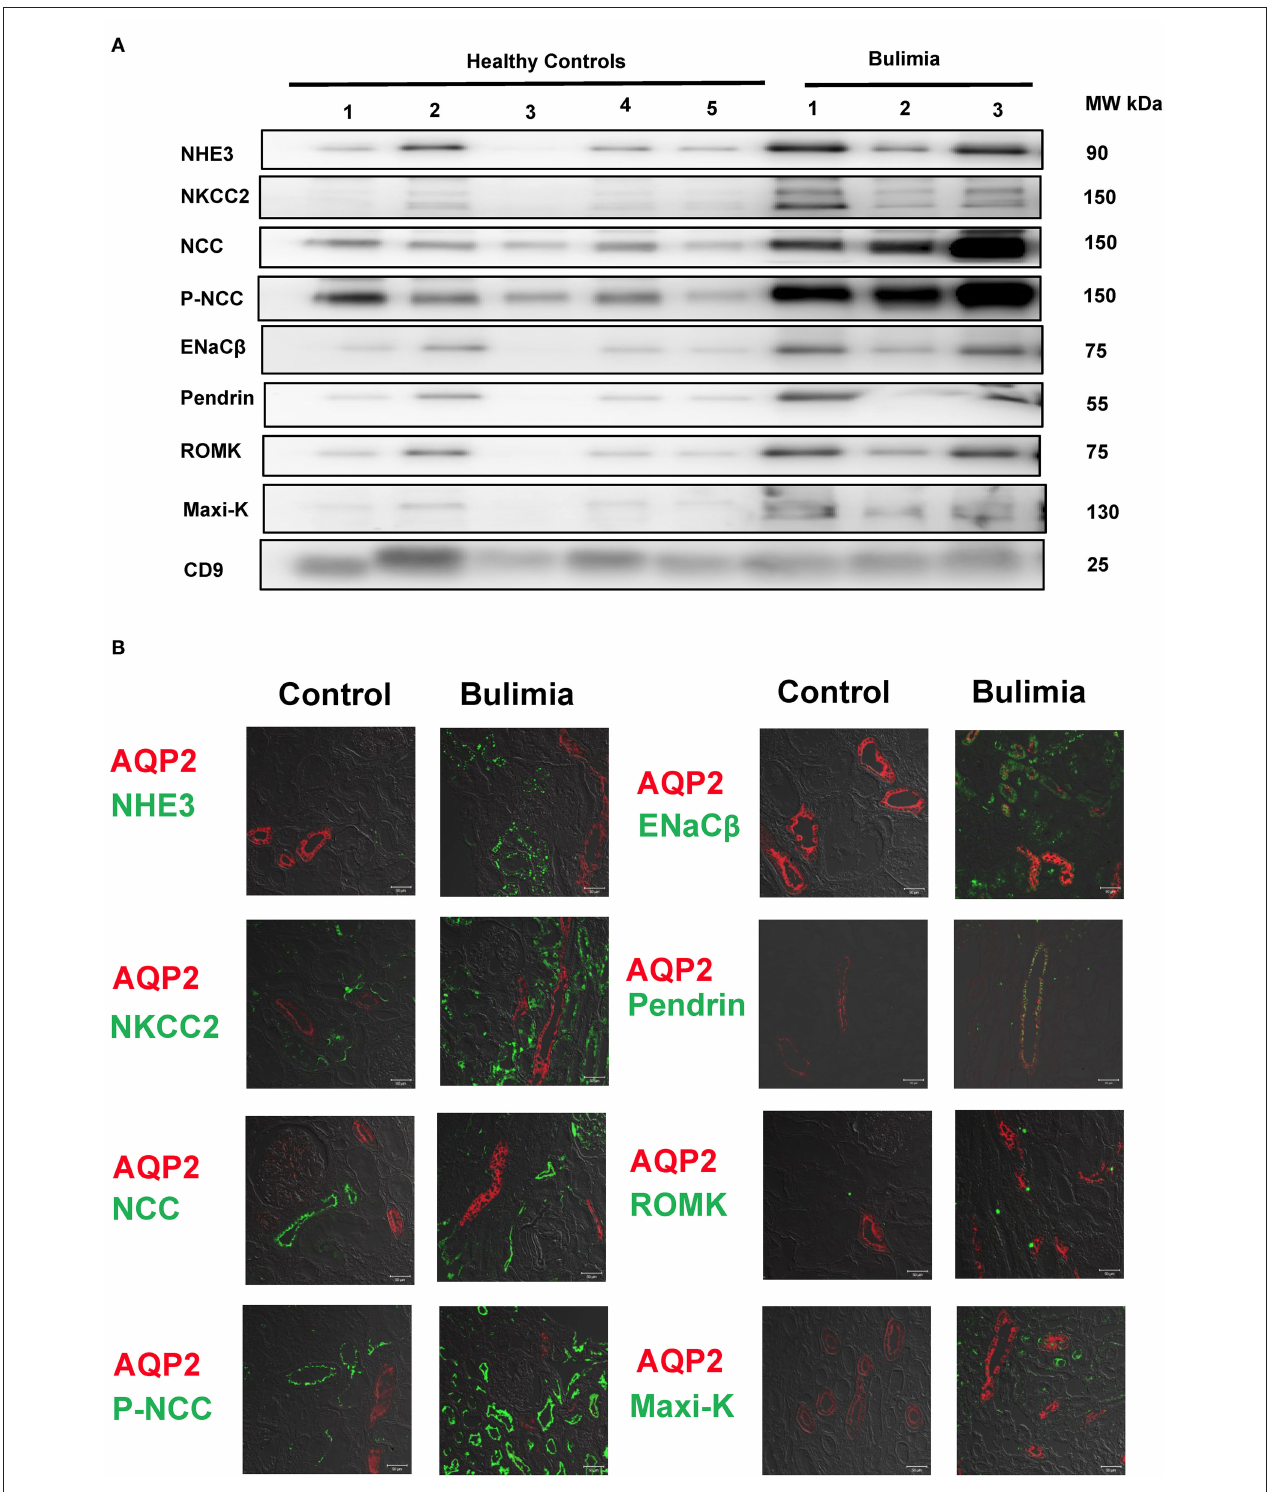
FIGURE 4 | Renal transporters expression from urinary extracellular vesicles (uEVs) and immunofluorescence of biopsied kidney tissues from bulimic patients. (A) Immunoblotting of renal transporters (NHE3, NKCC2, NCC, p-NCC, ENaC β , pendrin, ROMK, Maxi-K, and CD9) from uEVs in bulimic patients ( n = 3) compared with healthy control. (B) Immunofluorescence of NHE3, NKCC2, NCC, p-NCC (green, right ) and ENaC β , pendrin, ROMK, Maxi-K (green, left ) from one representative bulimia patient compared with the control. AQP2 was stained with red for localization. Scale bar, 50 µ m.